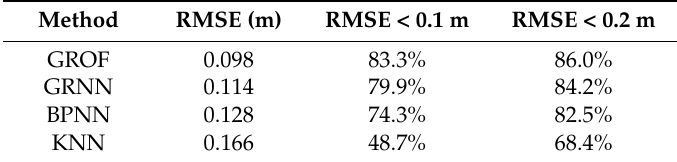
Table 5. Accuracy and precision of different algorithms in NLOS Case 2.